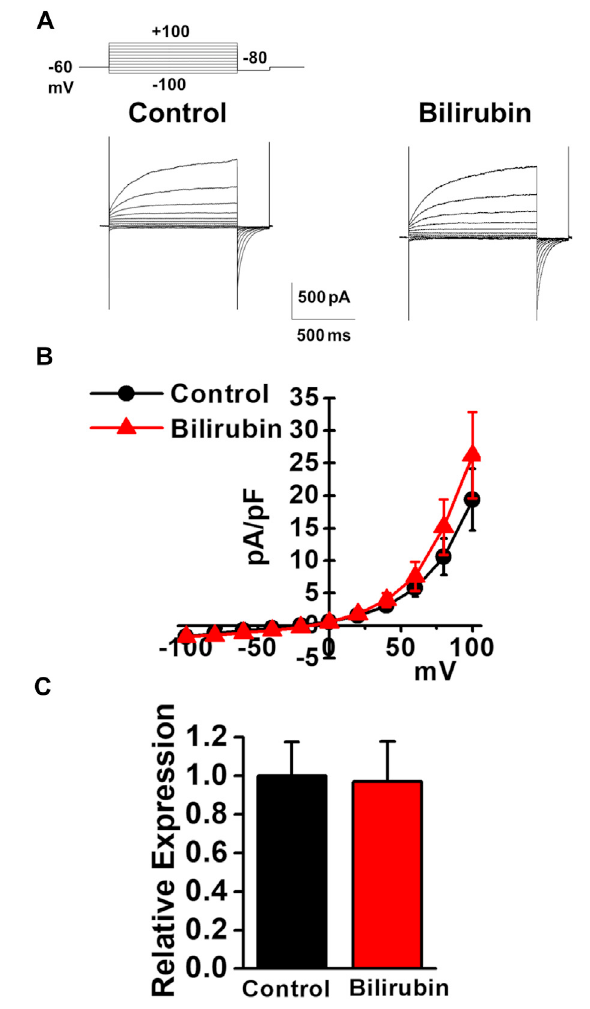
FIGURE 7 | Effects of angiotensin II on TMEM16A expression and currents in murine PVSMCs. Effects of angiotensin II on the expression and activity of TMEM16A channels were examined in murine PVSMCs. (A) Representative traces of Cl Ca currents in the absence and presence of 1 μ Mangiotensin II(Ang II)inPVSMCs. (B) Current-voltage (I-V)relationshipof Cl Ca currentsintheabsenceandpresenceofangiotensinIIinPVSMCs( n =4). (C) ExpressionlevelofTMEM16AmRNAinPVSMsaftertheexposureto1 μ M angiotensin II for 24 h ( n = 9 – 12). Data are presented as means ± S.E. * p < 0.05 versus vehicle